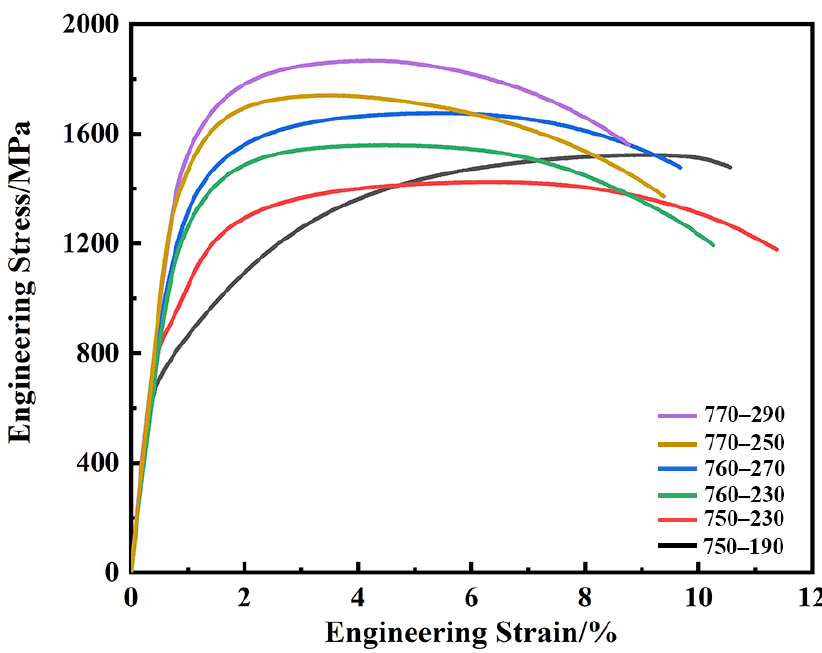
Figure 7. Tensile stress–strain curves after different processes.